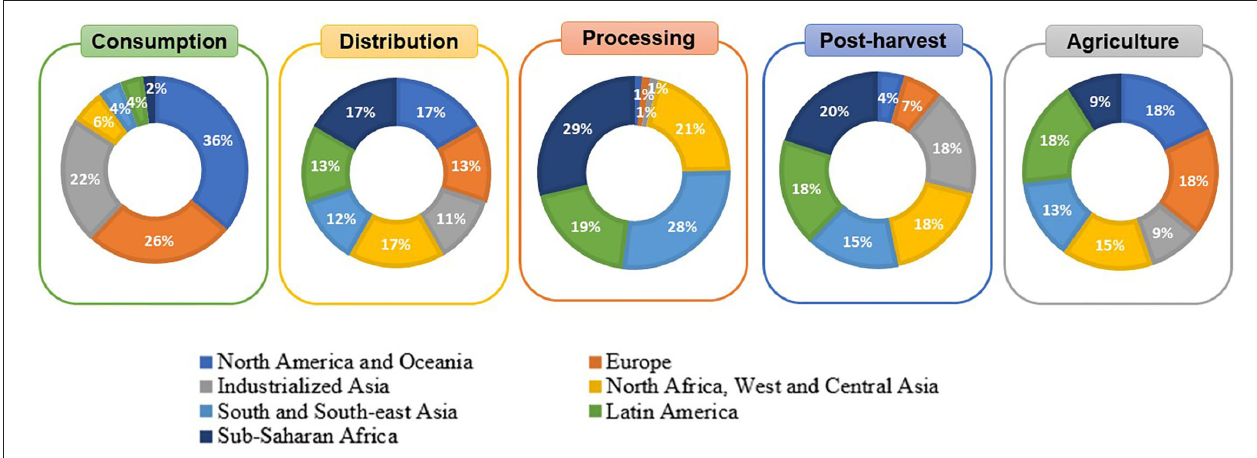
FIGURE 1 | Percentage of fruits and vegetables’ losses and wastes at different stages of the food supply chain in different regions. Each circle represents the total (100%) losses and wastes arising from each stage at the worldwide level. The contribution of each region (expressed in percentage) is also indicated in the Figure. Different colors represent different geographical regions. Information taken from reference (